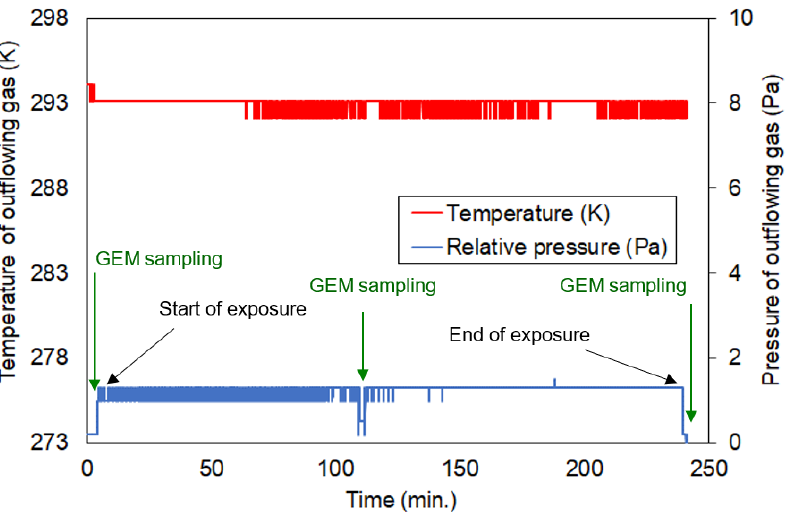
Figure 2. Time series plot of the temperature (T) and relative pressure (P) of the outflowing GEM standard gas from the glass vessel during the 4 h exposure experiment with a dilute nitric acid solution.